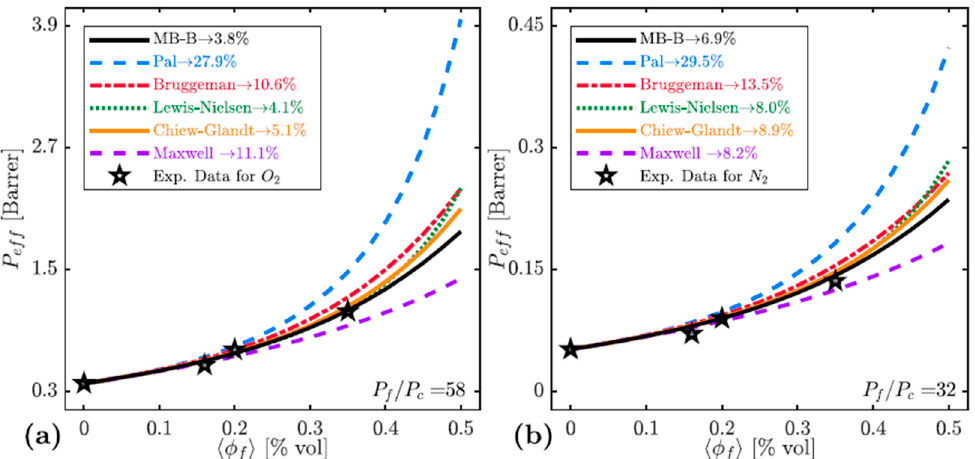
Figure 5. Comparison of experimental and theoretical ( a ) O 2 ( b ) N 2 permeabilities predicted from different effective medium theory based models for CMS/Ultem MMM. Adapted from Ref. [78].